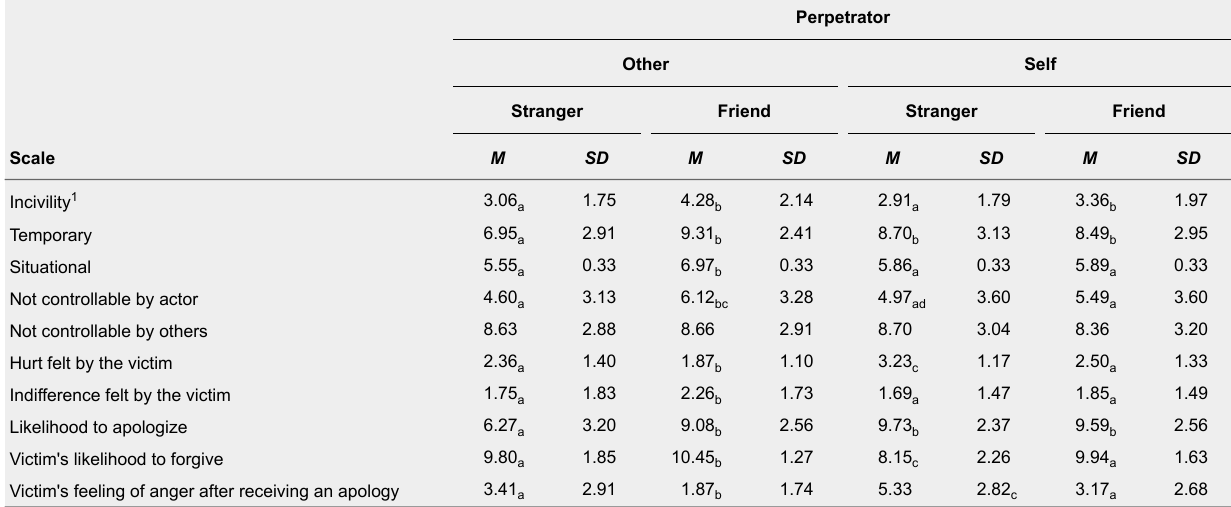
Means and Standard Deviations as a Function of Protagonist and Relationship (Study